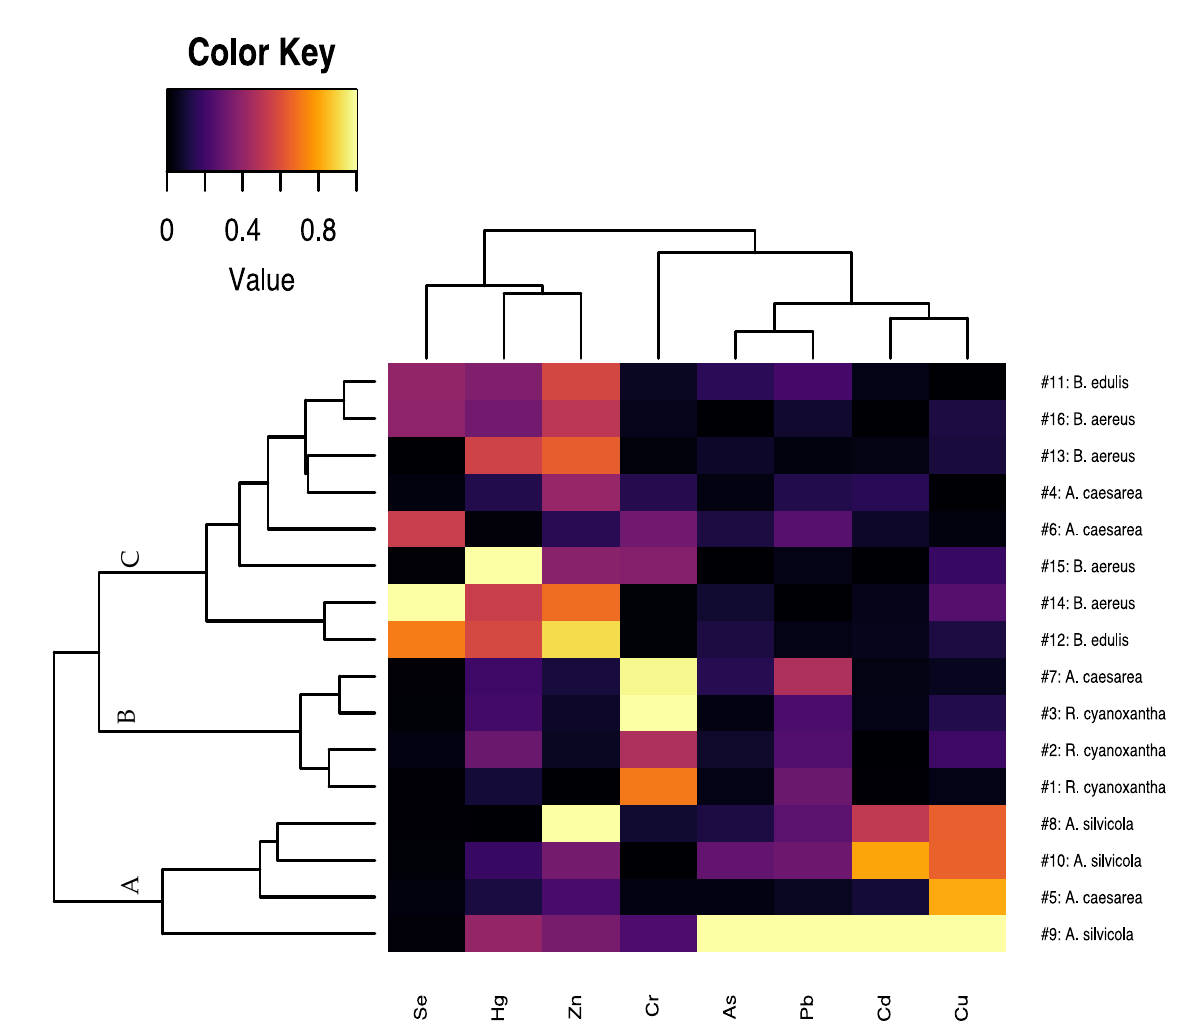
Figure 1. Graphical combination of the resulting HCA dendrograms with a heatmap to identify clustering trend patterns among the studied mushroom species based on the content of the eight elements determined.